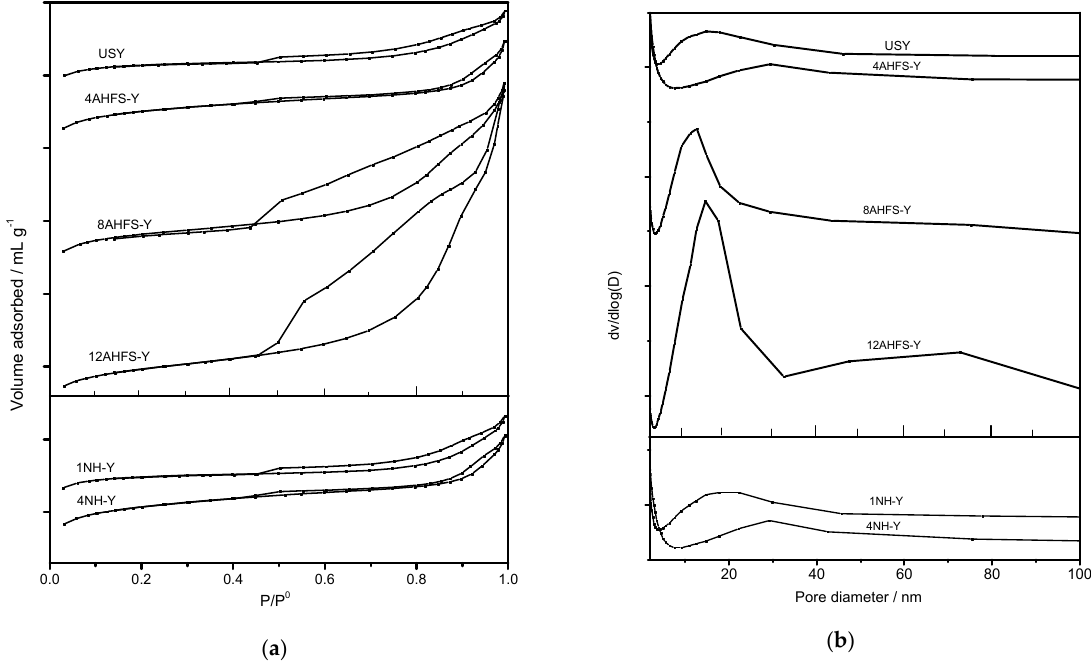
Figure 2. ( a ) N 2 adsorption–desorption isotherms and ( b ) the mesopore size distribution for the AHFS-treated and alkaline-treated USY.